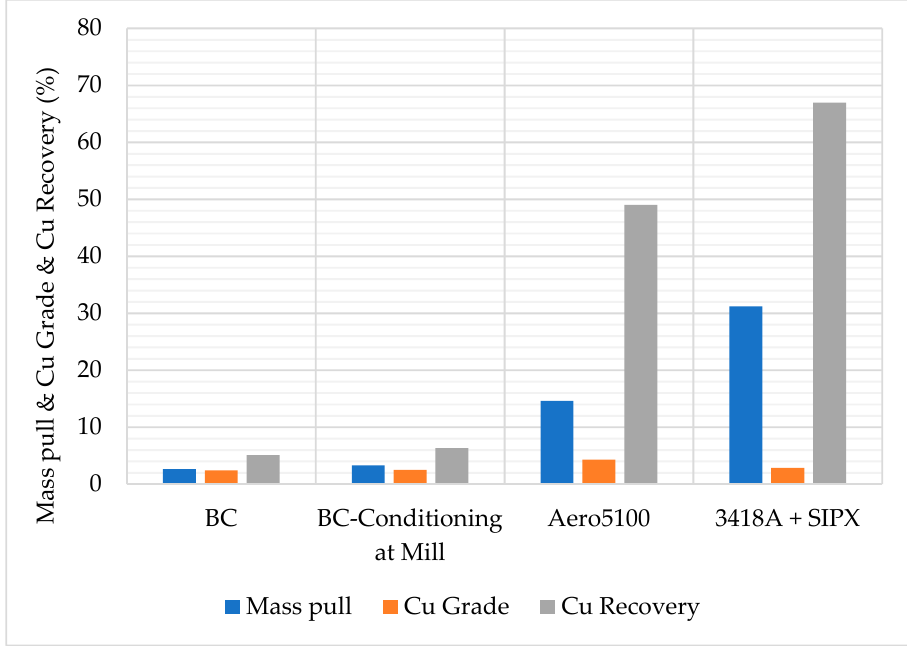
Figure 5. Effect of different reagent applications on the rougher flotation performance of Ore B.